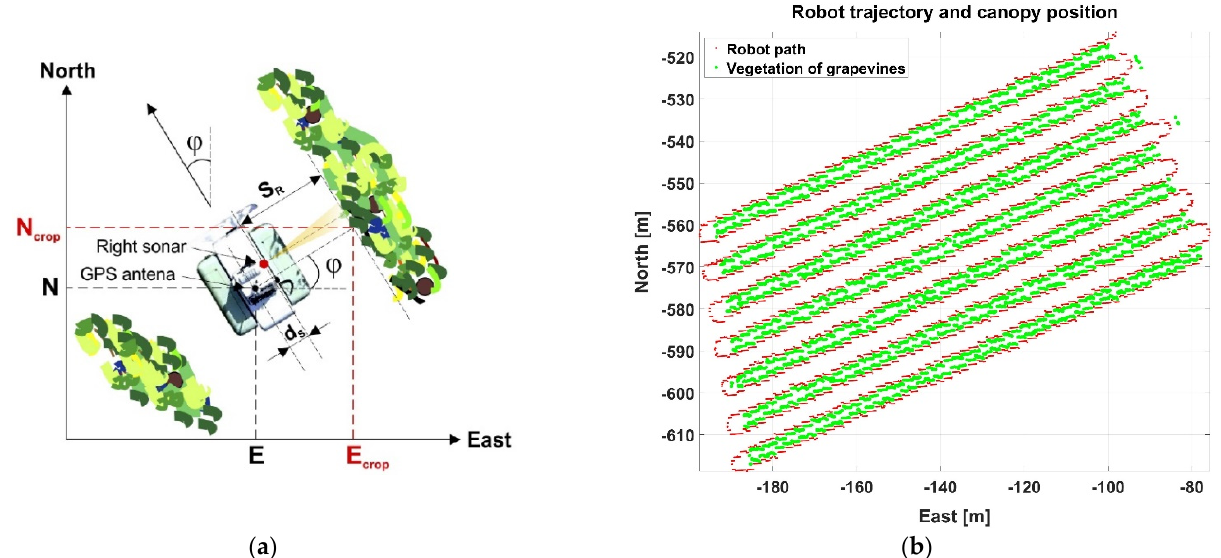
Figure 1. Derivation of crop coordinates from vehicle coordinates: ( a ) problem description; and ( b ) results on a commercial vineyard from a scouting robot.